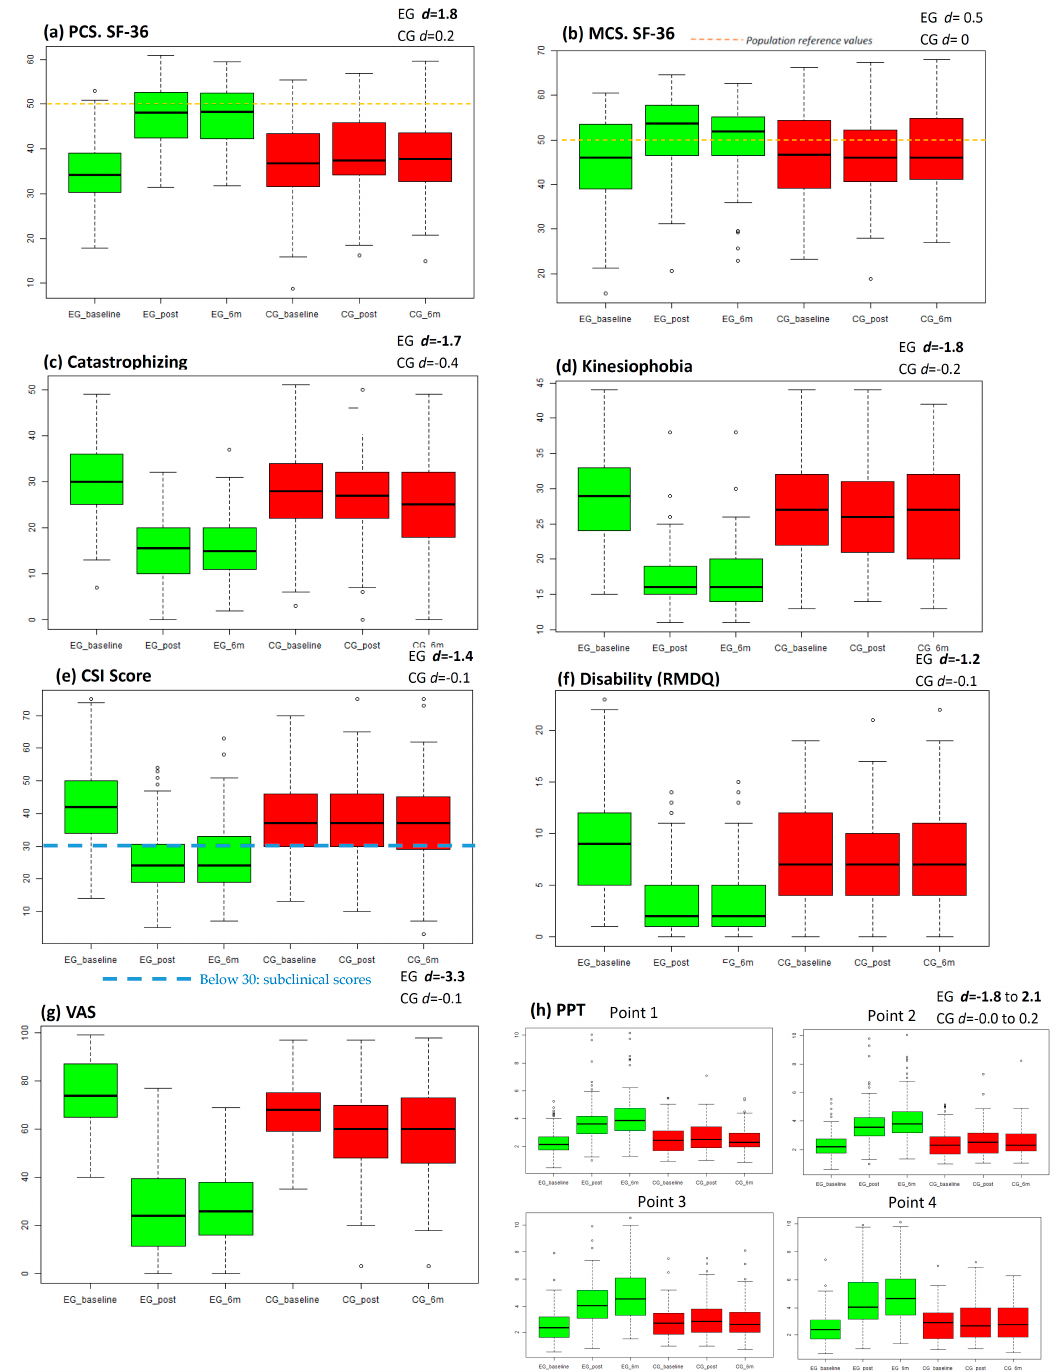
Figure 3. Outcome graphical representation. This figure contains outcomes graphical representation in boxplot. Green colour represent experimental group (EG) and red colour represent control group (CG). First boxplot represents the initial assessment, the second boxplot represents post-intervention assessment and the third the assessment at six months; ( A ) Boxplot for physical component summary (PCS); ( B ) Boxplot for mental component summary (MCS); ( C ) Boxplot for catastrophism outcomes; ( D ) Boxplot for kinesiophobia outcomes (TSK-11); ( E ) Boxplot for CSI scores (part A); ( F ) Boxplot for disability (RMDQ); ( G ) Boxplot for intensity of pain (VAS; ( H ) boxplot for PPT outcomes; EG d = X.X: Experimental Group e ff ect size at six months (Cohen’s d ); CG d = X.X: Control group e ff ect size at six months. Hollow circles represents outlier